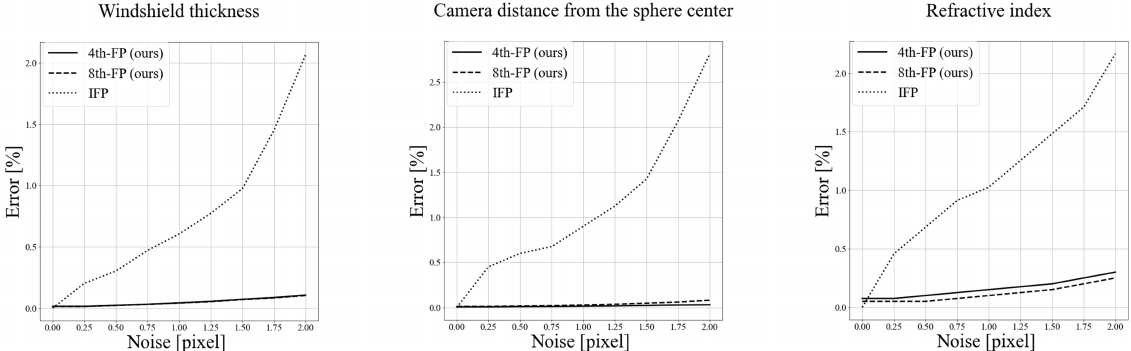
Figure 4: Quality of estimation of system parameters as a function of increasing Gaussian noise with a 2-D calibration target. All evaluations are done for the proposed 4th and 8th degree polynomials and compared to the backward-projection model.